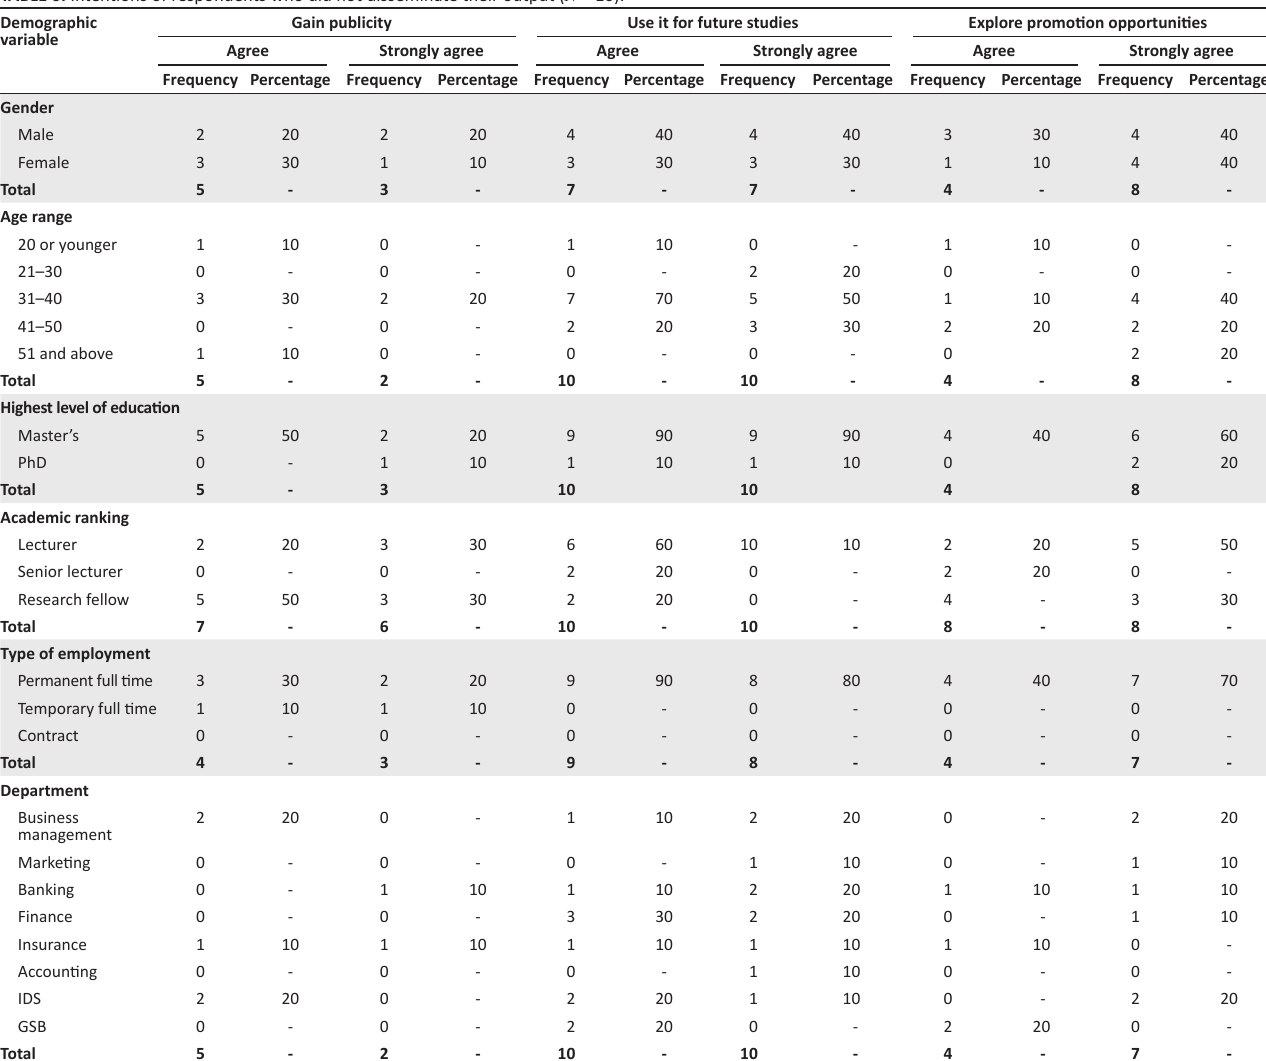
TABLE 6: Intentions of respondents who did not disseminate their output ( N = 10). Demographic